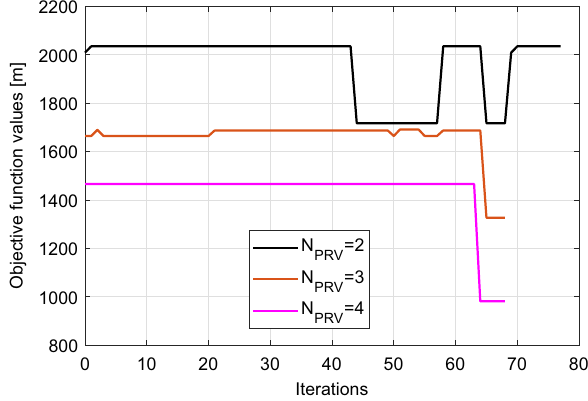
Fig. 2 Profile of objective function values for N prv =